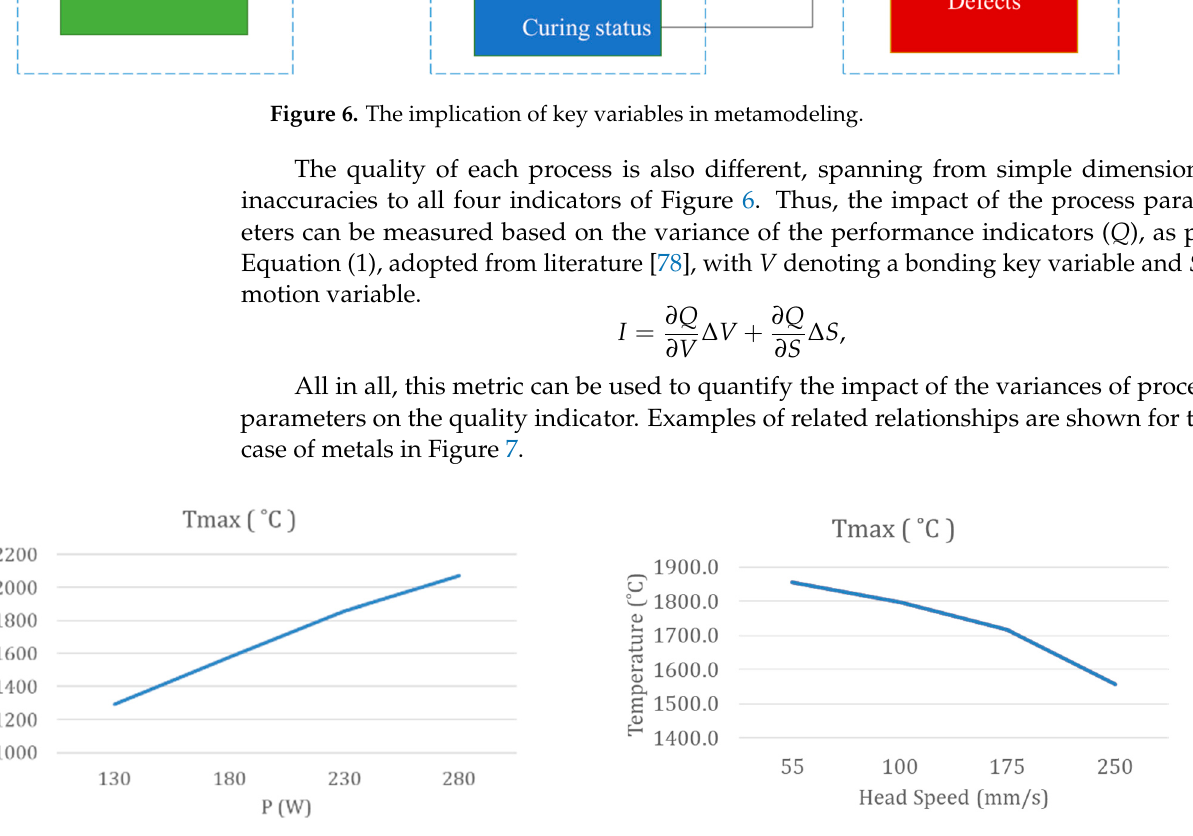
Figure 6. The implication of key variables in metamodeling.